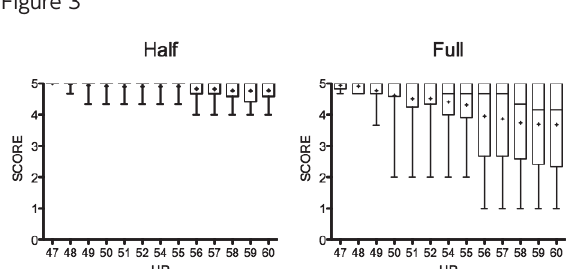
Relation between the mean evaluation points of the evaluators and the heart rate for each reconstruction algorithm. For patients with a high heart rate,